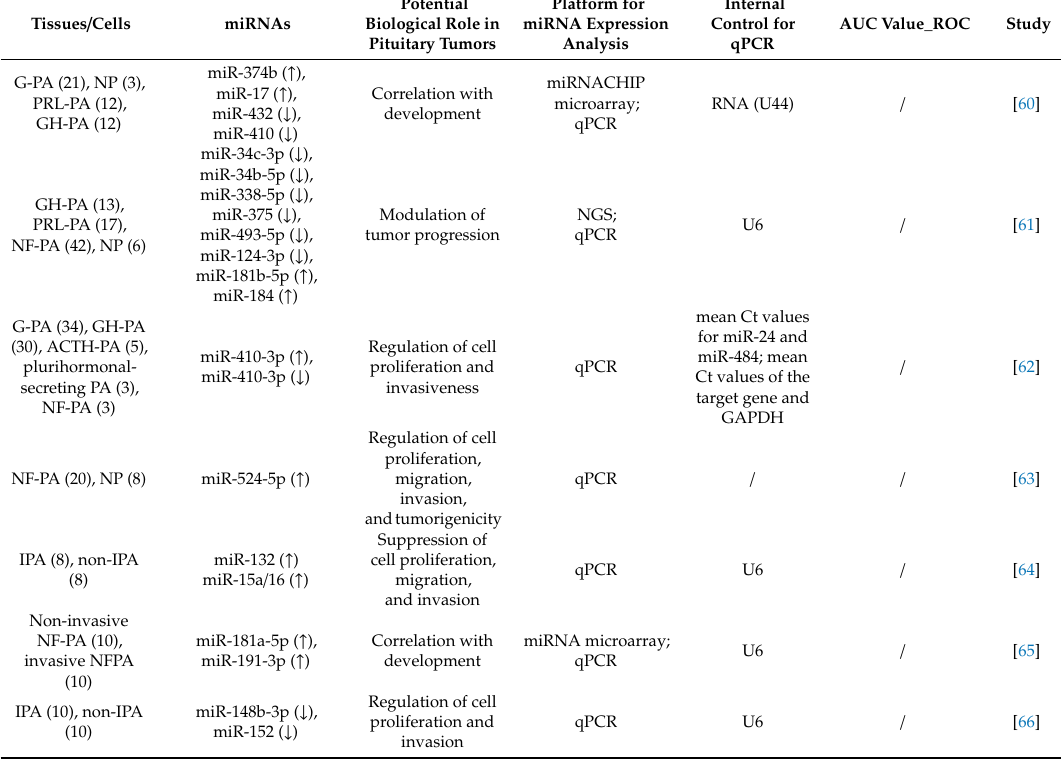
Table 3. Overview of di ff erentially expressed miRNA in pituitary